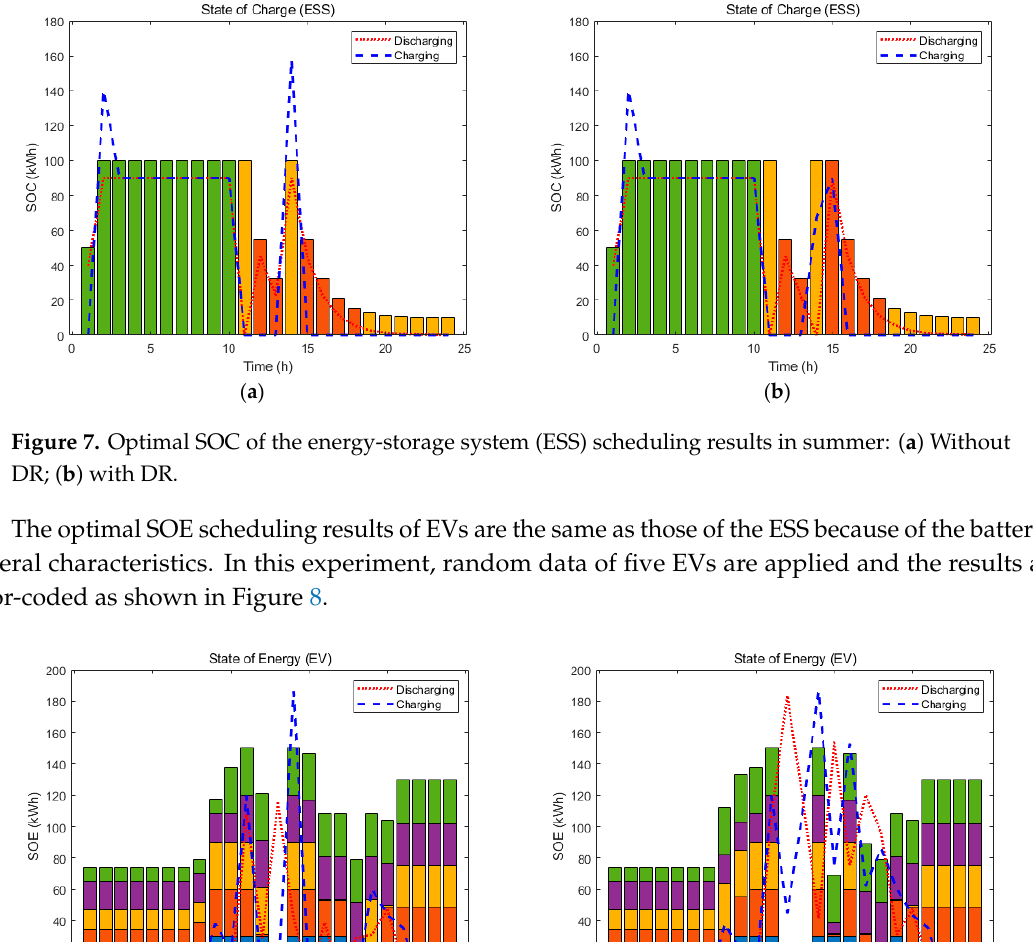
Figure 6. Optimal load consumption scheduling results in summer: ( a ) Without DR; ( b ) with DR.